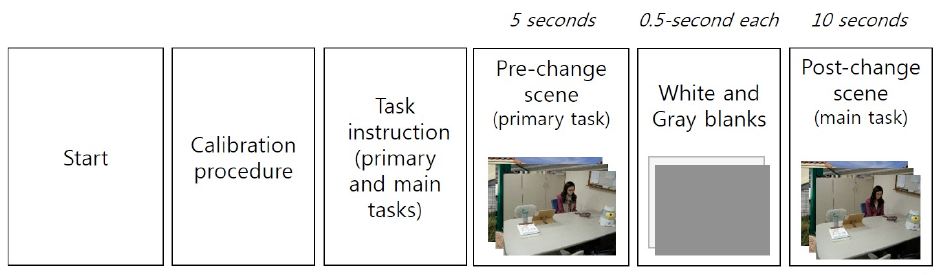
Figure 1. Experimental